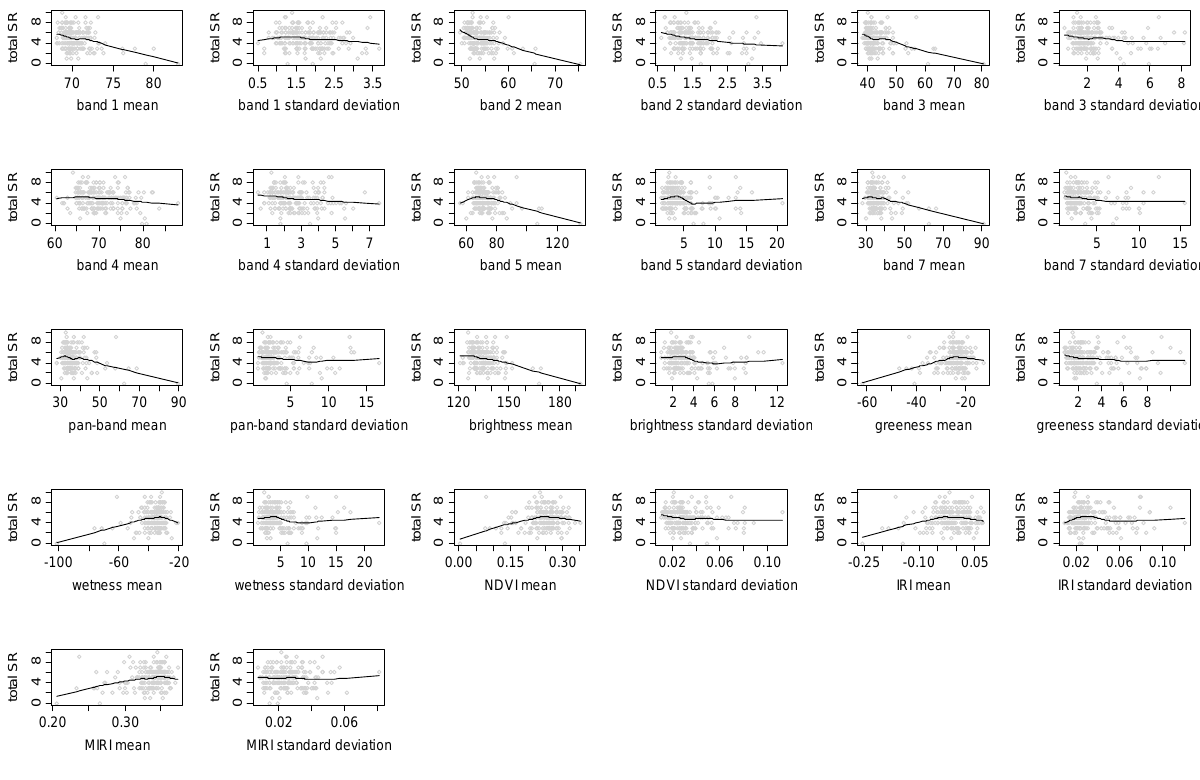
Figure 2. Scatterplots of total species richness (SR) vs. Landsat ETM+ spectral variables. Fitted curves represent LOWESS based smoothing.